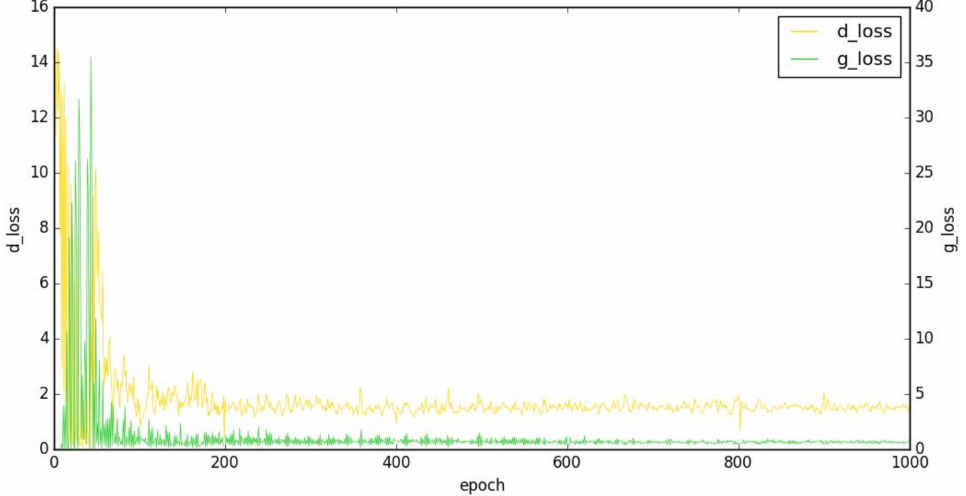
Figure 8. How the loss of discriminator (d_loss) and generator (g_loss) changes with increasing